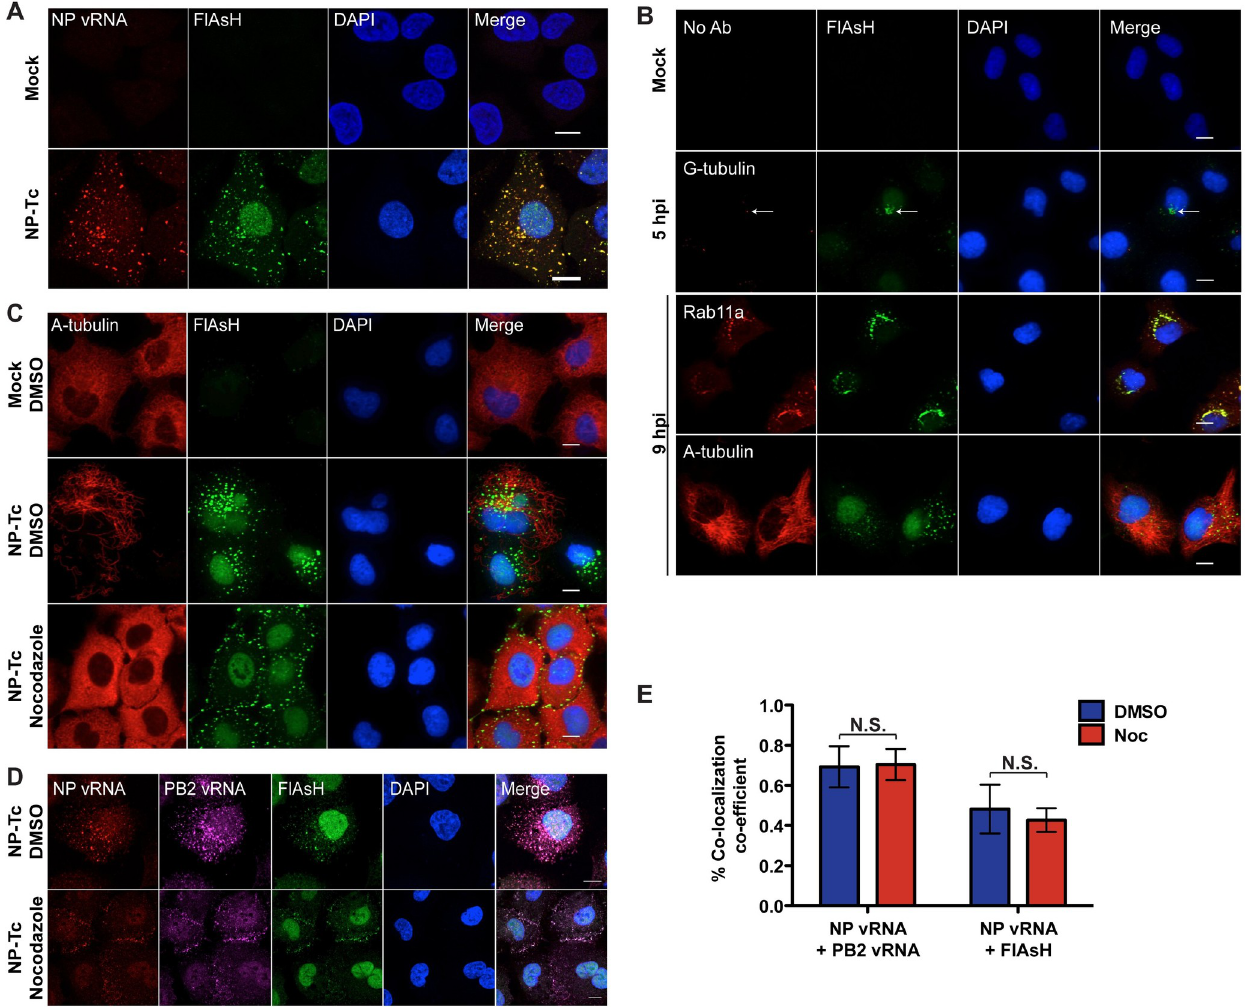
Fig 2. NP-Tc tag allows for visualization of vRNP interactions with cellular components. (A) FlAsH staining of NP-Tc marks vRNP complexes. A549 cells were infected with NP-Tc virus at MOI = 1 for 7 hours, and stained with FlAsH dye and FISH (Quasar570) probes against NP vRNA. Scale bar = 10 μ m. (B) Localization of vRNP complexes with cytoskeletal structures and trafficking factors. A549 cells were infected with NP-Tc virus at MOI = 1 for the indicated time points, and stained with FlAsH dye, and antibodies for the cellular factors γ -tubulin, Rab11a, and α -tubulin. Scale bar = 10 μ m. (C) Disruption of the microtubule network disperses vRNPs to the plasma membrane. A549 cells infected with NP-Tc virus at MOI = 1 were treated with 30 μ M nocodazole or DMSO starting at 3 hpi and were stained with FlAsH dye and an α -tubulin antibody at 9 hpi. Scale bar = 10 μ m. (D and E) Association of vRNPs may not rely on the microtubule network. A549 cells infected with NP-Tc virus at MOI = 1 were treated with 30 μ M nocodazole (Noc) or DMSO starting at 3 hpi. At 8 hpi, cells were stained with FlAsH dye and FISH probes against NP vRNA (Quasar570) and PB2 vRNA (Quasar670). Scale bar = 10 μ m. Cytoplasmic signals were analyzed for co-localization by fluorescence microscopy (D) and through Manders Coefficient analysis for FlAsH (NP-Tc) with PB2 or NP vRNA FISH probes (E). At least 9 cells per condition were analyzed. � p-value < 0.05; �� p-value < 0.01; ��� p-value < 0.001; N.S., non-significant. Data are representative of at least three independent